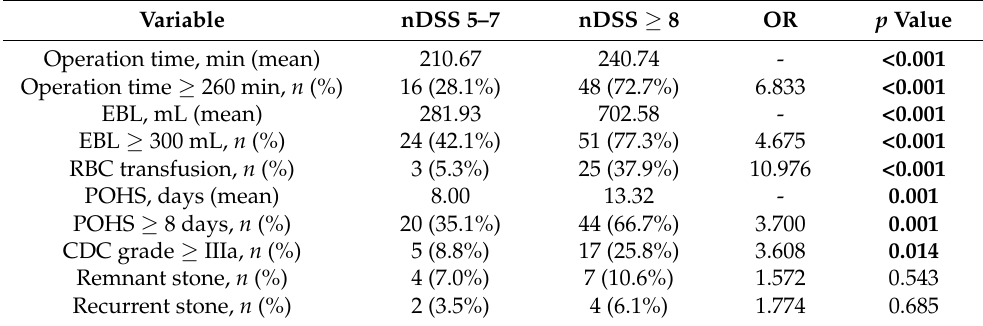
Table 5. Surgical outcomes in patients divided into high and low nDSS